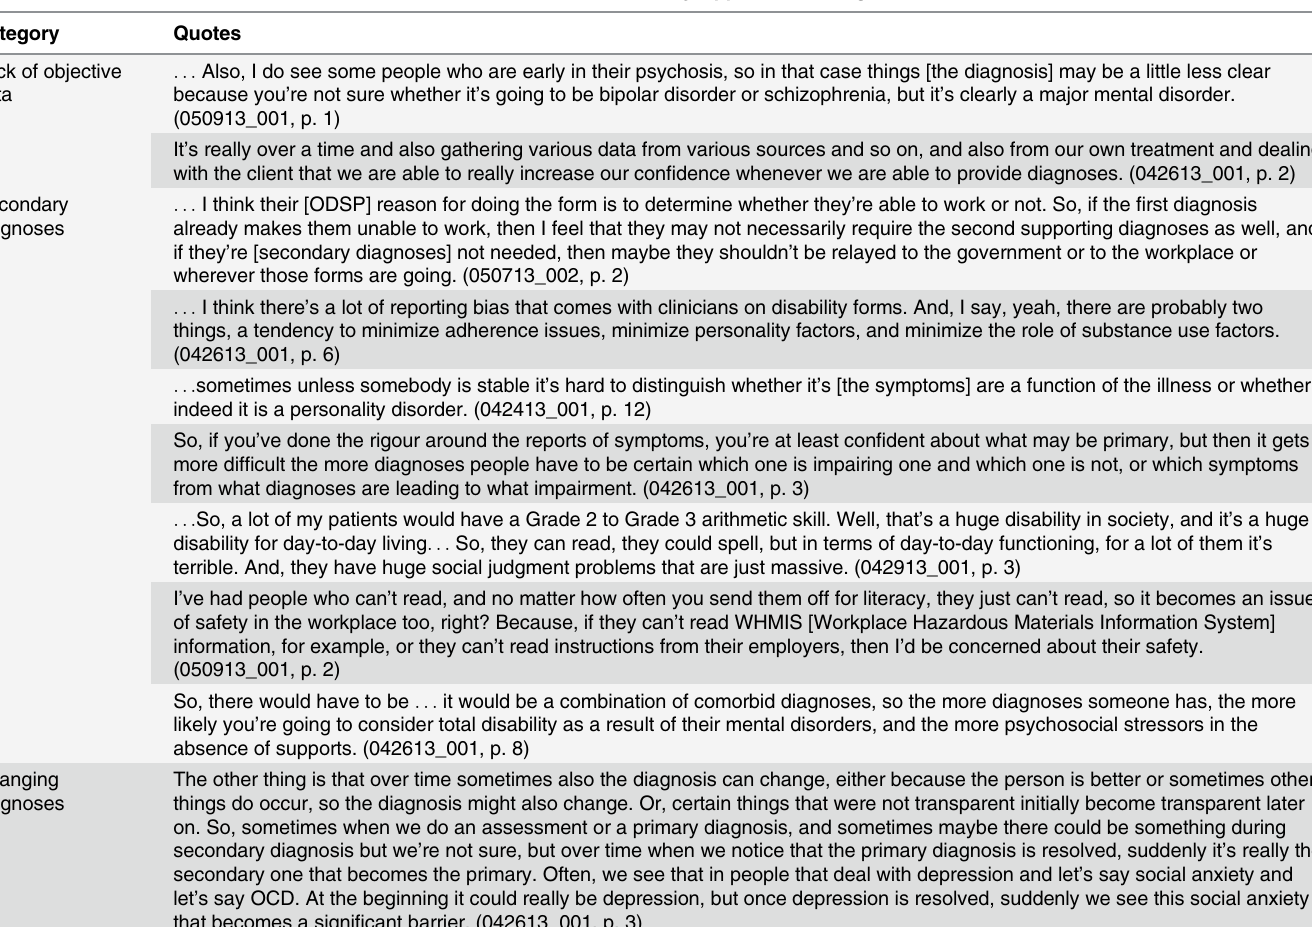
Table 1. Theme of Differences between the Medical Record and the Disability Application Categories and Quotes.